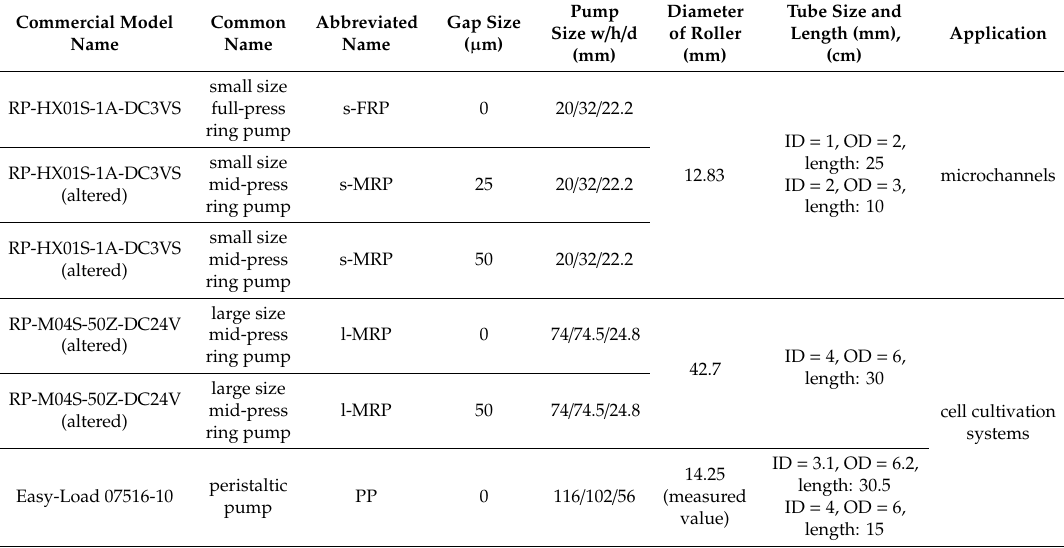
Table 1. Correspondence table showing names of pumps. Abbreviations: OD–outer diameter; ID–inner